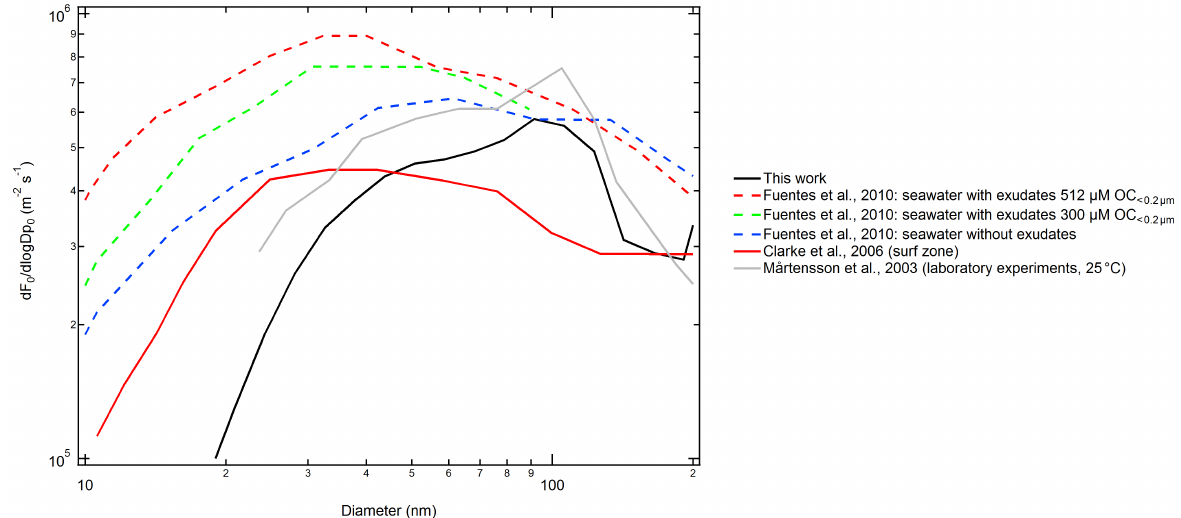
Figure 5. Comparison of size-resolved source flux measurements from previously published work and this work.